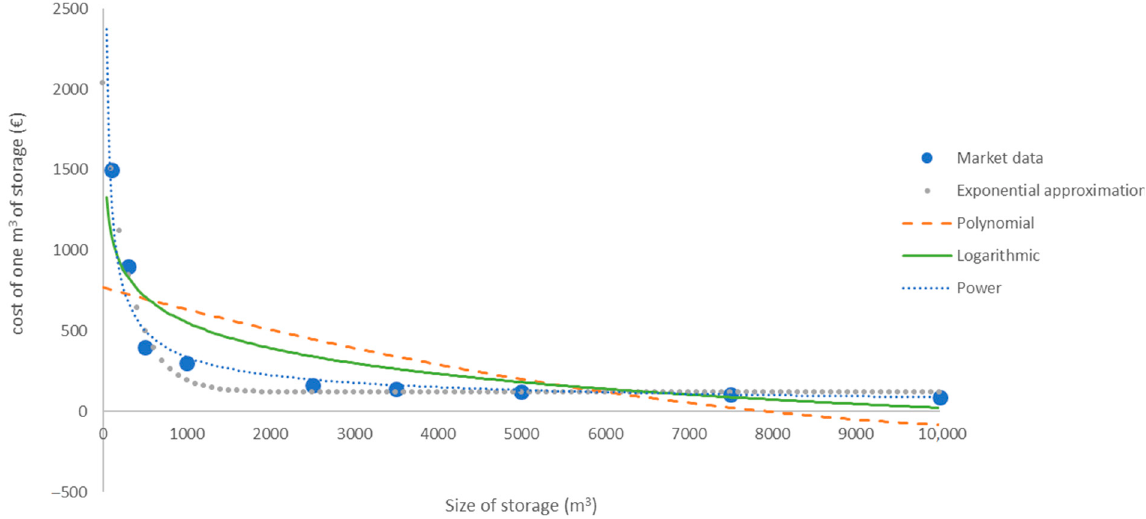
Figure 7. Approximation of market data with different approaches.